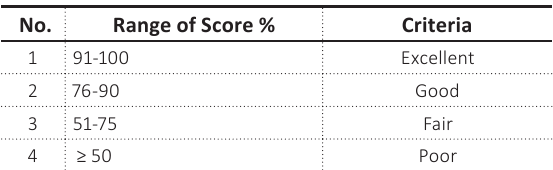
Table 2. Criteria qualification